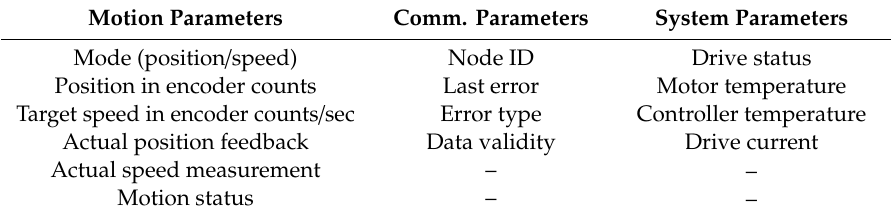
Table 2. List of actuator parameters for command and monitoring.